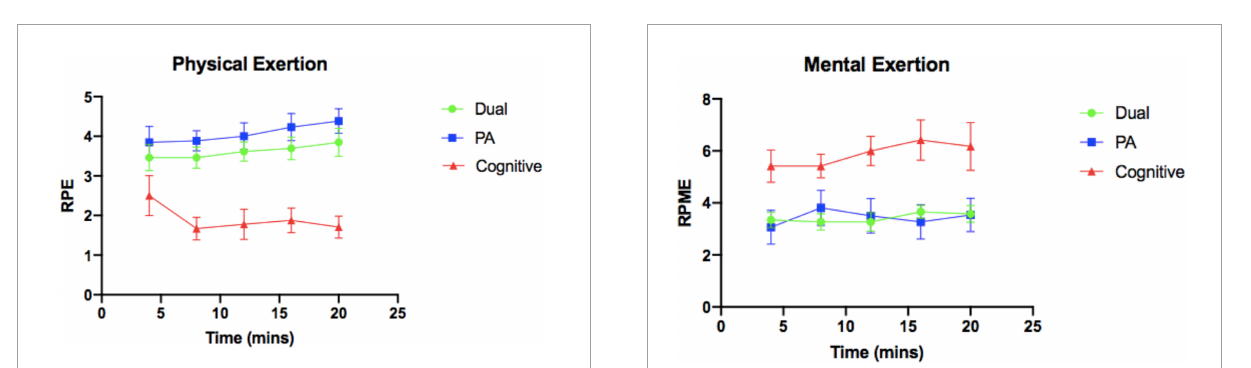
FIGURE1 Physical exertion over 20-min intervention. RPE, Ratings of Perceived Exertion; PA, physical activity.